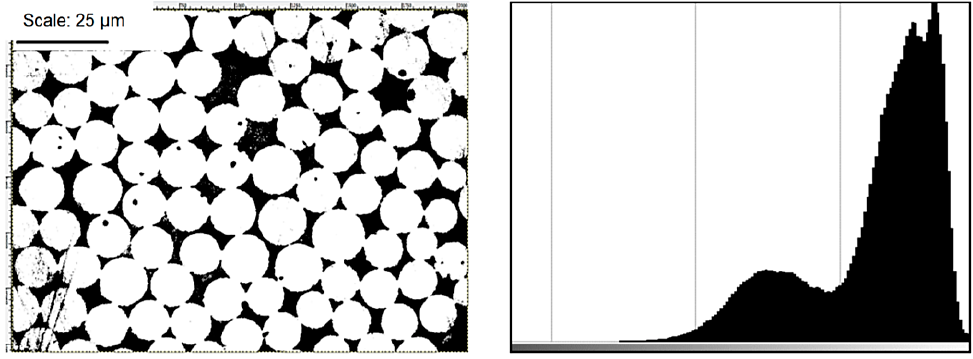
Figure 7. Example of a structure and its histogram.